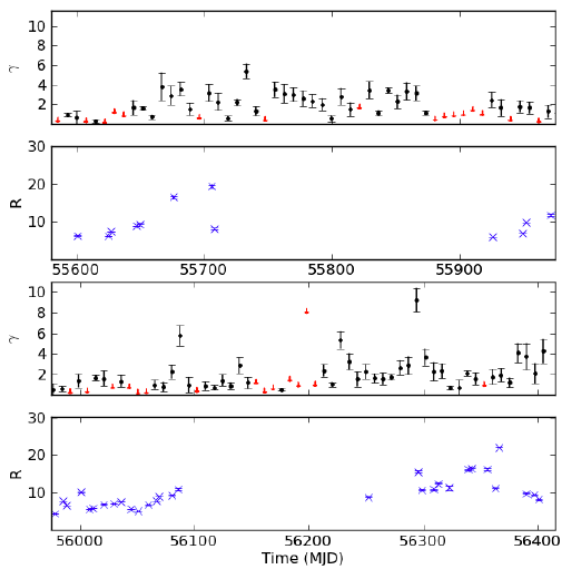
Figure 3. Quasi-simultaneous gamma-ray and optical R-band data for J0948+0022.